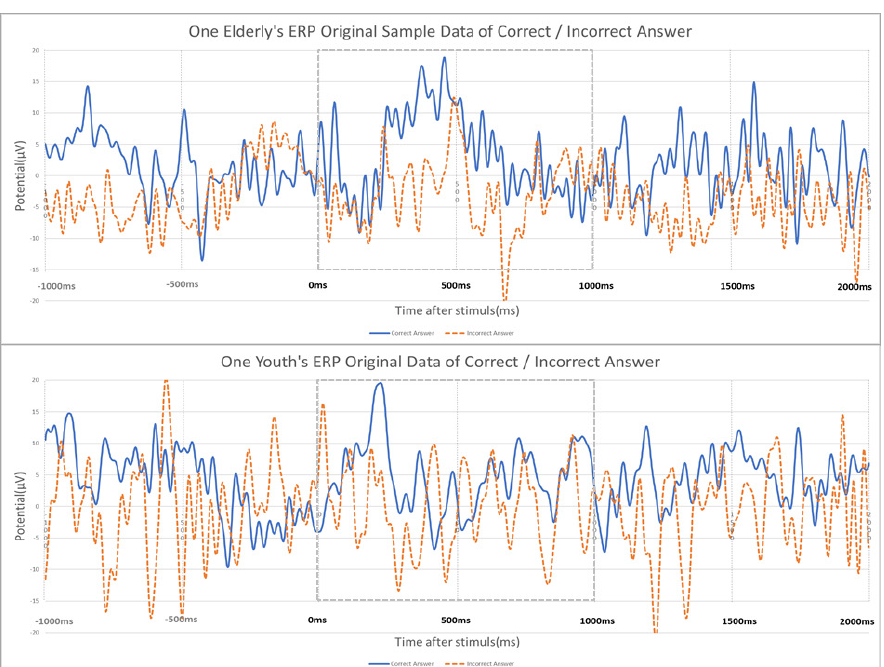
Figure 5. Original ERP (Cz, central vertex) data of an elderly/young subject (#1) from − 1 to 2 s: In this study, the data from 0 to 1 s where the main components of ERP are located are the main targets.